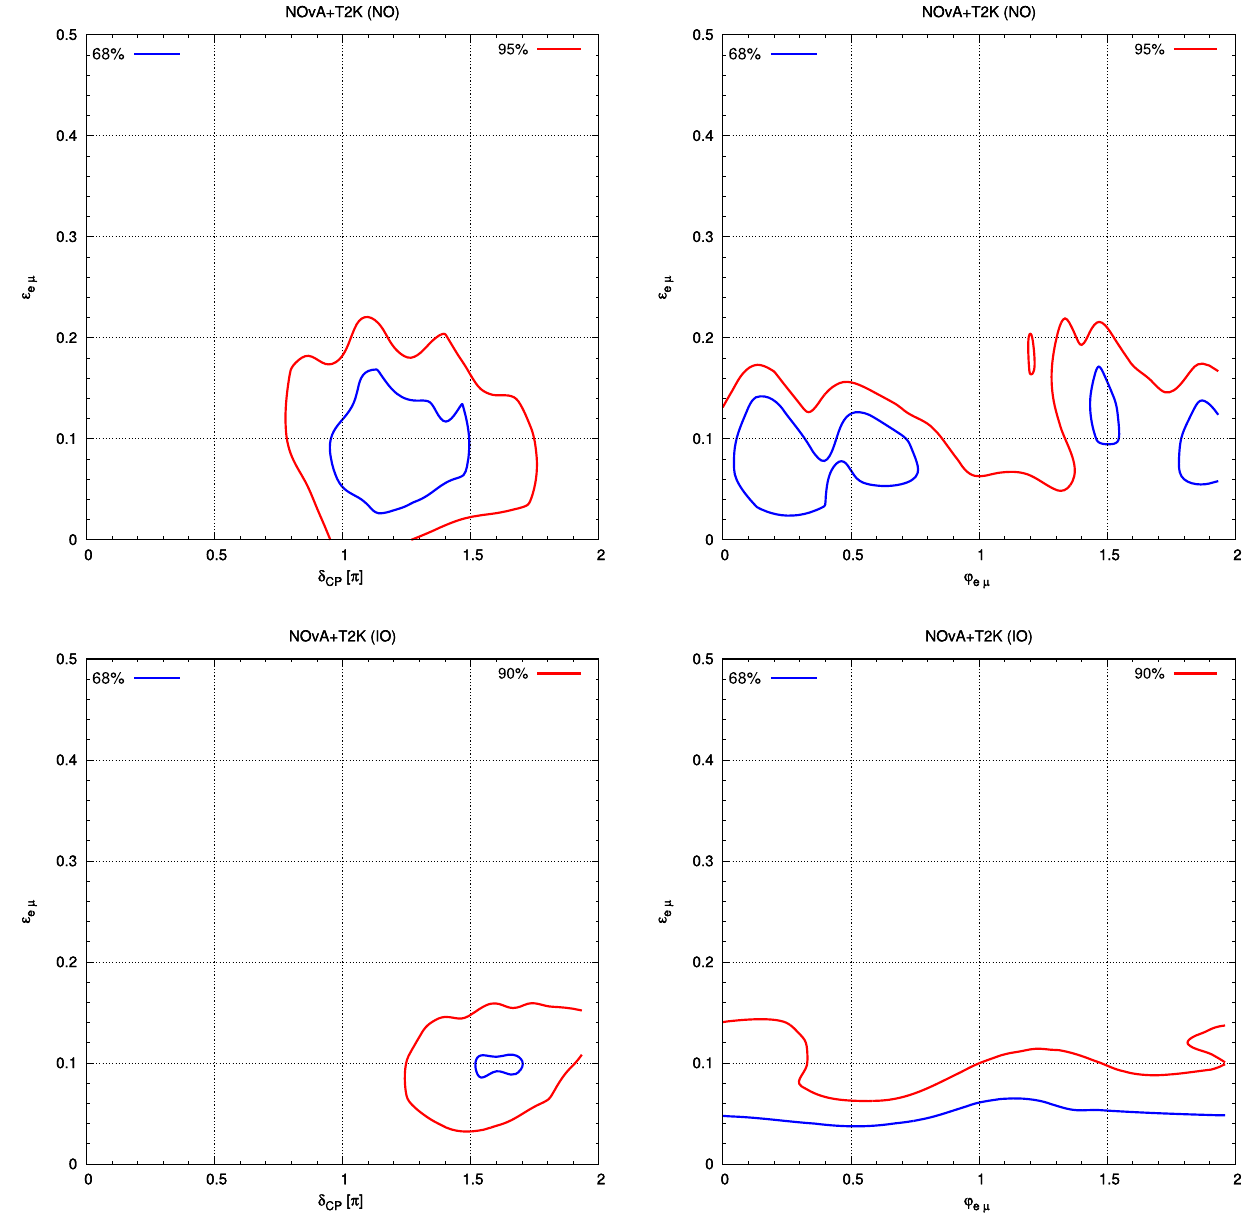
Fig. 1 Allowed regions for (cid:5) e μ and the CP phase (left); (cid:5) e μ and phase φ e μ (right) determined by the combination of T2K and NO ν A for NO (top panel) and IO (bottom panel). The contours are drawn at the 68% and 90% C.L. for 2 d.o.f